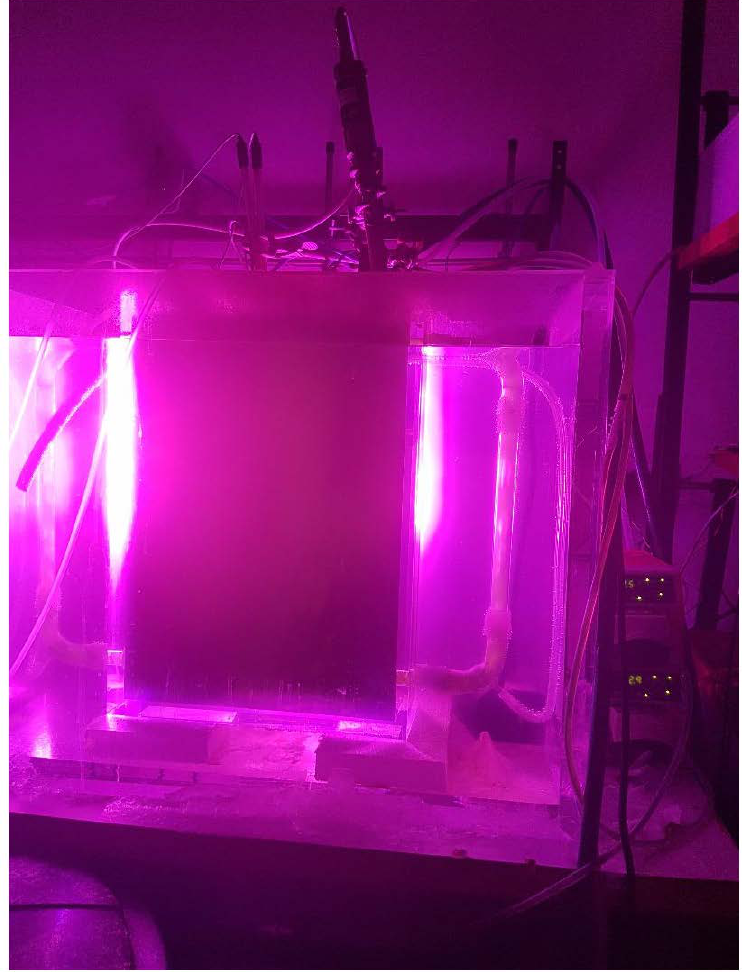
Figure 14. Lab-scale flat photobioreactor—reproduced with permission from